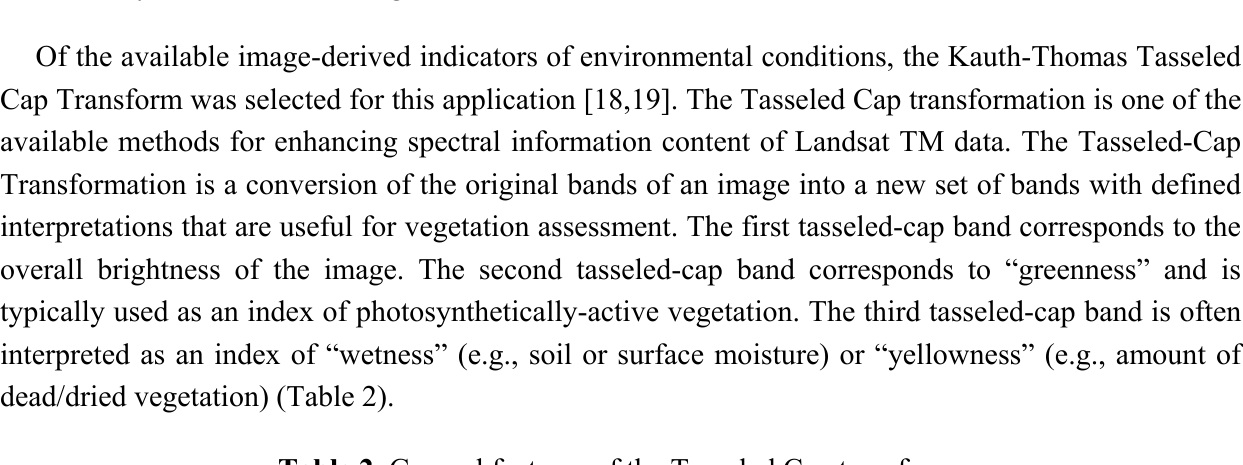
Table 2. General features of the Tasseled Cap